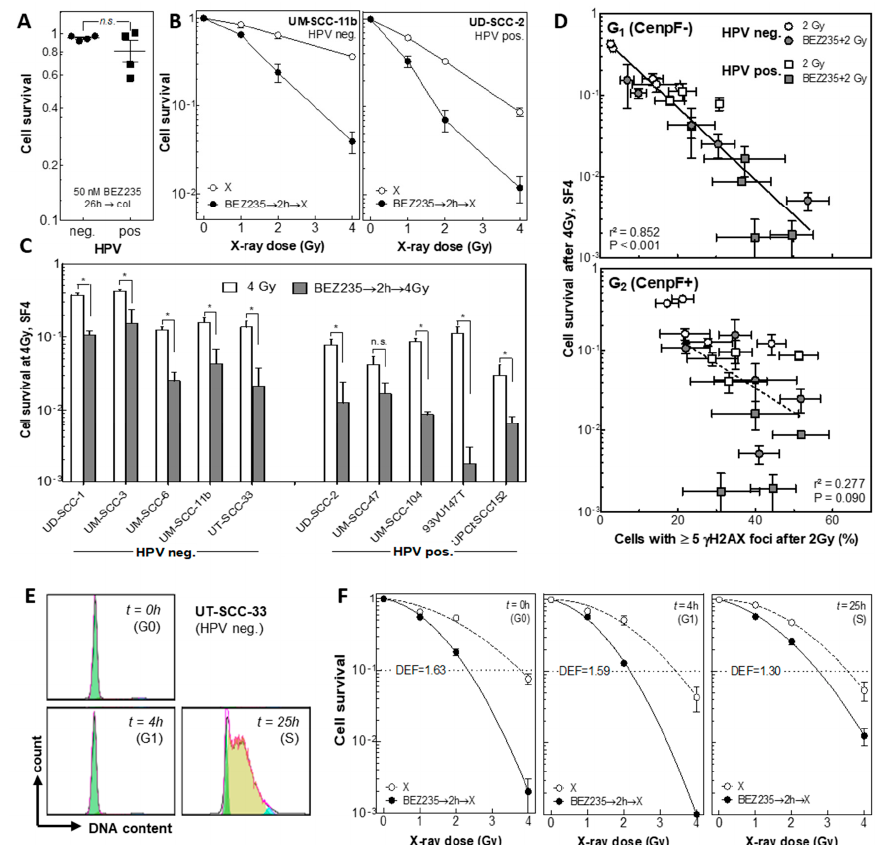
Figure 5. E ff ect of BEZ235 on cellular radiosensitivity of HPV neg. and pos. cell lines. 22 h after seeding cells were incubated with BEZ235 (50 nM) for 2 h, then irradiated. After 24 h BEZ235 was removed and colonies were allowed to grow up to 21 days. ( A ) Effect of BEZ235 on cell survival. ( B ) Effect of BEZ235 on UM-SCC-11 and UD-SCC-2 cells irradiated with X-ray doses up to 4 Gy. ( C ) Effect of BEZ235 on cell survival in four HPV neg. and pos. cell lines irradiated with 4 Gy (SF4). Significant differences between conditions are shown with asterisks (p-value < 0.05). ( D ) Association between cell survival and DSB repair after irradiation alone or in combination with BEZ235. Percentage of cells with ≥ 5 foci as determined either for G1 or G2 phase cells (Figure 3C,D) was plotted vs. the cell survival measured at 4 Gy (SF4). Data were analyzed by linear regression. ( E , F ) E ff ect of BEZ235 on cellular radiosensitivity in dependence of cell cycle. ( E ) Cell cycle distribution of UT-SCC-33 cells 0, 4, and 25 h after re-stimulation of quiescent cultures representing G0, G1, and S-phase population. ( F ) E ff ect of BEZ235 on radiosensitivity of UT-SCC-33 cells irradiated either in G0, G1, or